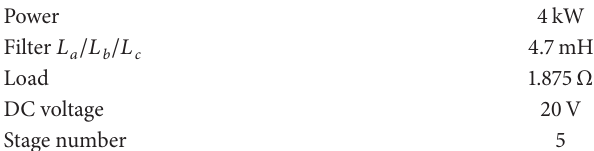
Table 6: Parameters about 11-level CHB